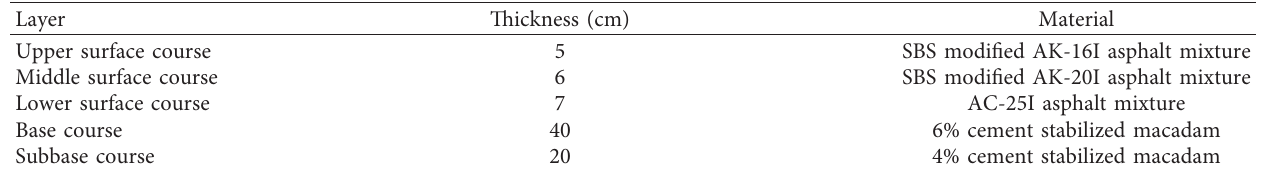
Table 2: Main parts of pavement